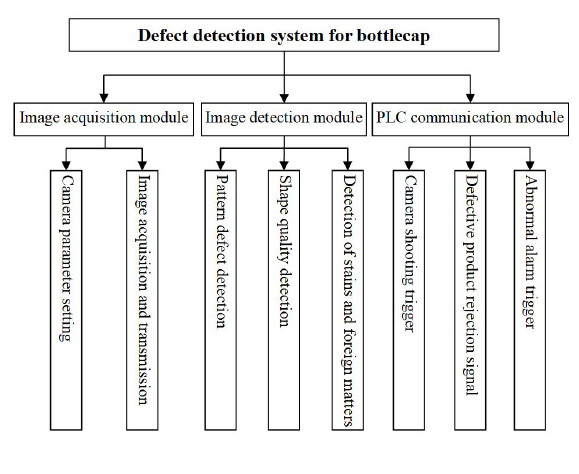
Fig. 5. Program composition of the system